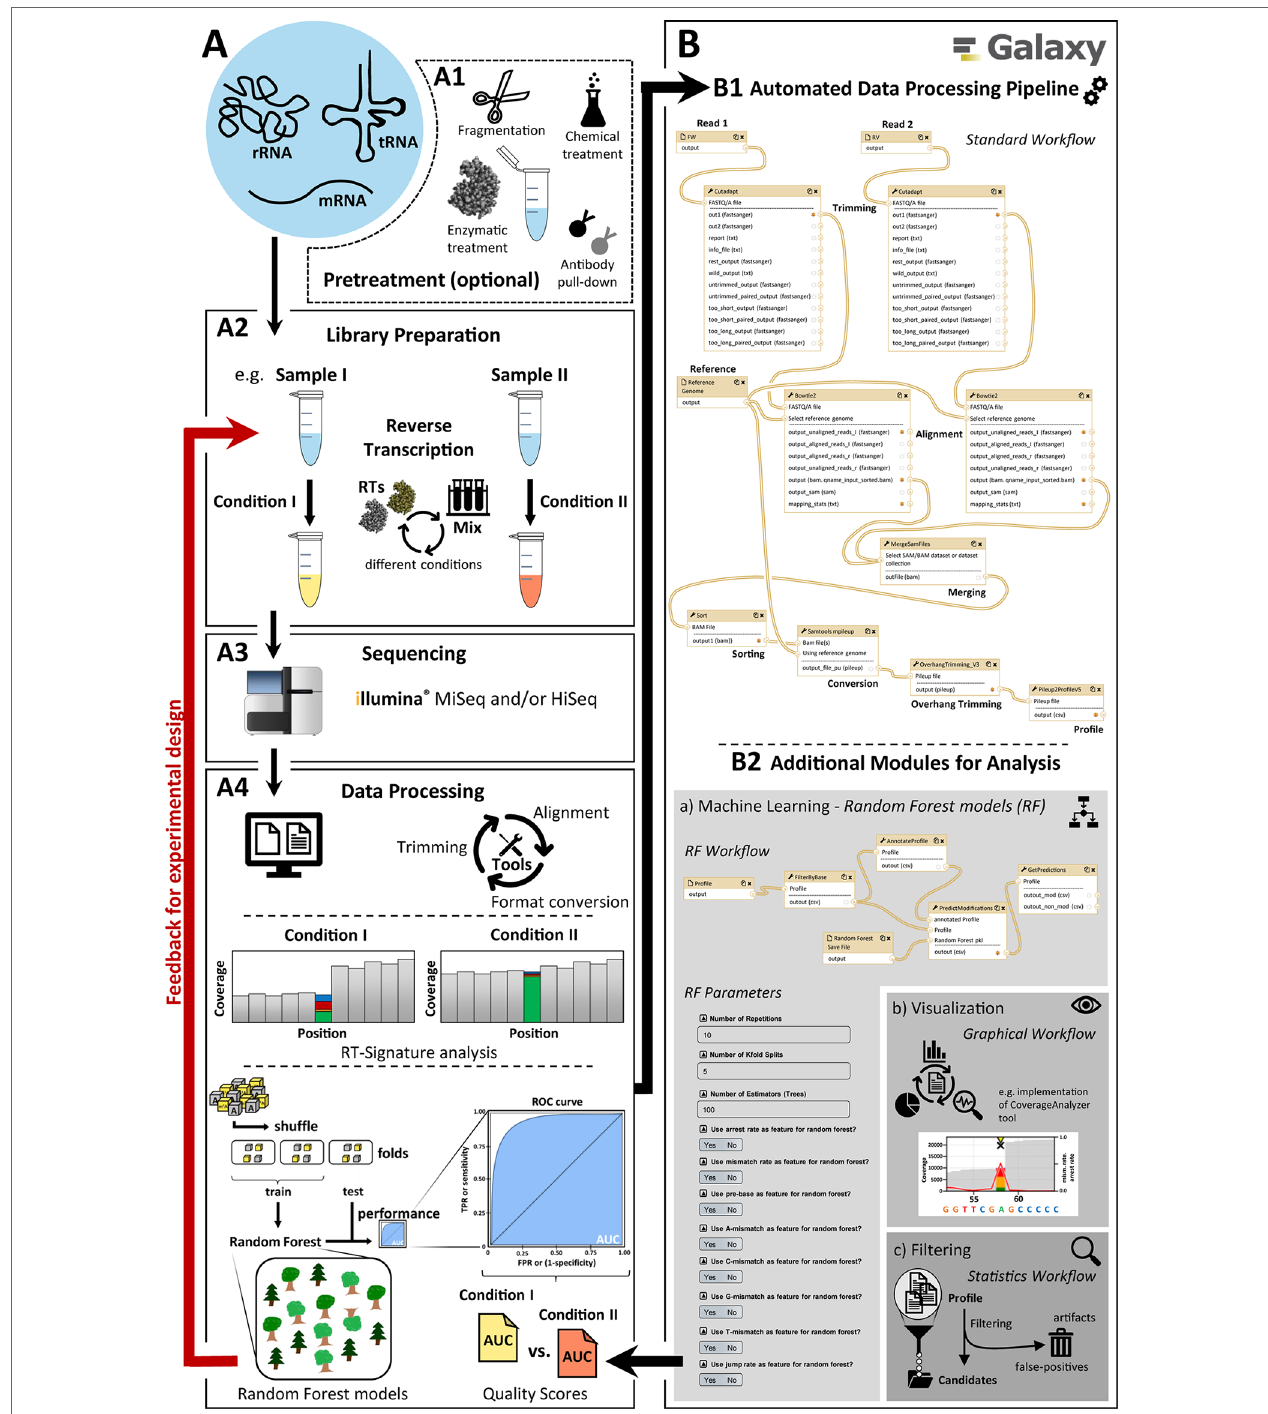
FIGURE 1 | Main overview of the modification calling pipeline. A diagram showing the different steps for creating and analyzing RNA-Seq data. The pipeline has two parts: (A) general workflow for the processing of RNA samples and (B) the implemented automated graphical workflow system with the available modules for bioinformatics data analysis. (A) consists of (A1) possible and partly necessary pretreatments for different RNA species, (A2) library preparation with the possibility of adaptations (e.g. conditions for reverse transcription), (A3) sequencing with Illumina sequencing platforms (e.g. MiSeq/NextSeq and HiSeq), and (A4) data processing including basic data treatment like adapter trimming, alignment, and format conversion, as well as data analysis (e.g. machine learning and RT-signature analysis). The elaborate data processing (A4) was fully automated in (B) by using the open-source Galaxy platform to create and provide a quick and user-friendly feedback mechanism to optimize the experimental design, sample preparation, and data processing. The standard workflow (B1) is supplemented by various additional modules (B2) including workflows for (a) machine learning, (b) visualization, and (c)